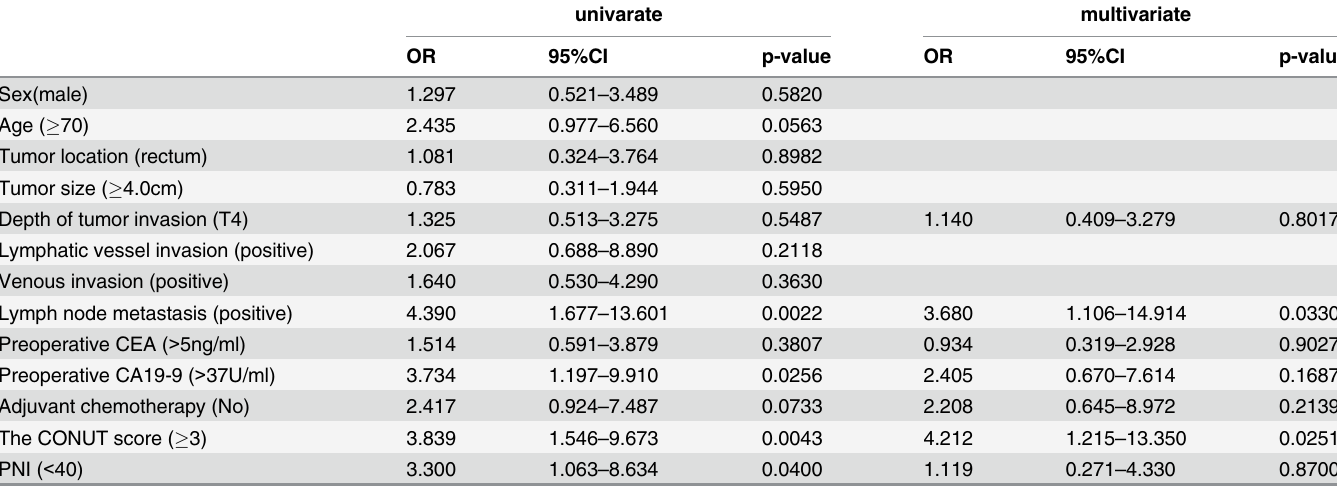
Table 5. The results of the univariate and multivariate analyses of the prognostic factors for the cancer-specific survival (CSS). univarate